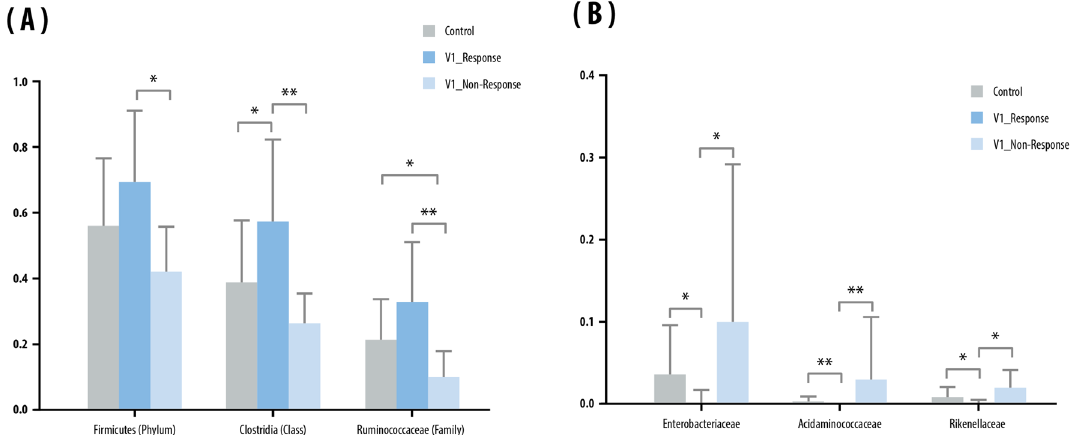
Figure 2. Stool: microbials abundant in the stool of the control and inflammatory bowel disease (IBD) groups before anti-TNF-α treatment (V1). Mean relative abundance of: ( A ) microbials abundant in the responder group (phylum class, family); and ( B ) microbials abundant in the non-responder group (family). Kruskal–Wallis and Wilcoxon tests were used. Bars above columns indicate standard deviation. * p < 0.05; ** p < 0.01.